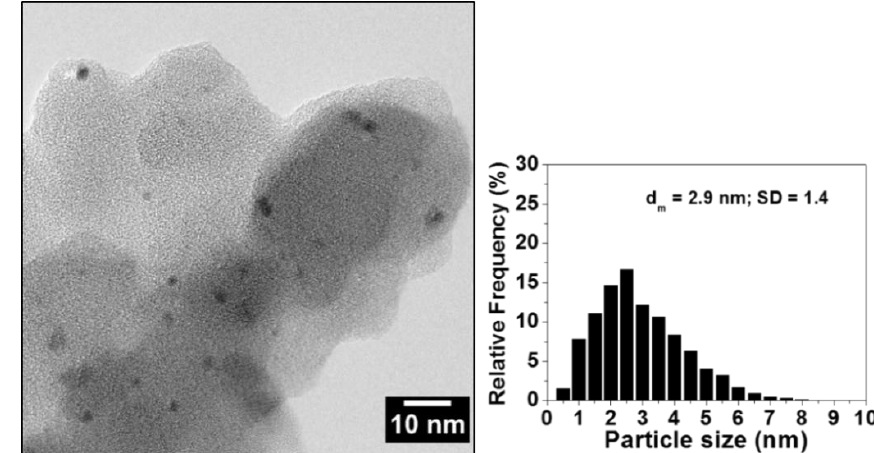
Figure 1. Representative transmission electron microscopy micrograph and histogram of particle size distribution of the polyvinylpyridine-supported palladium catalyst (Pd/PVPy).